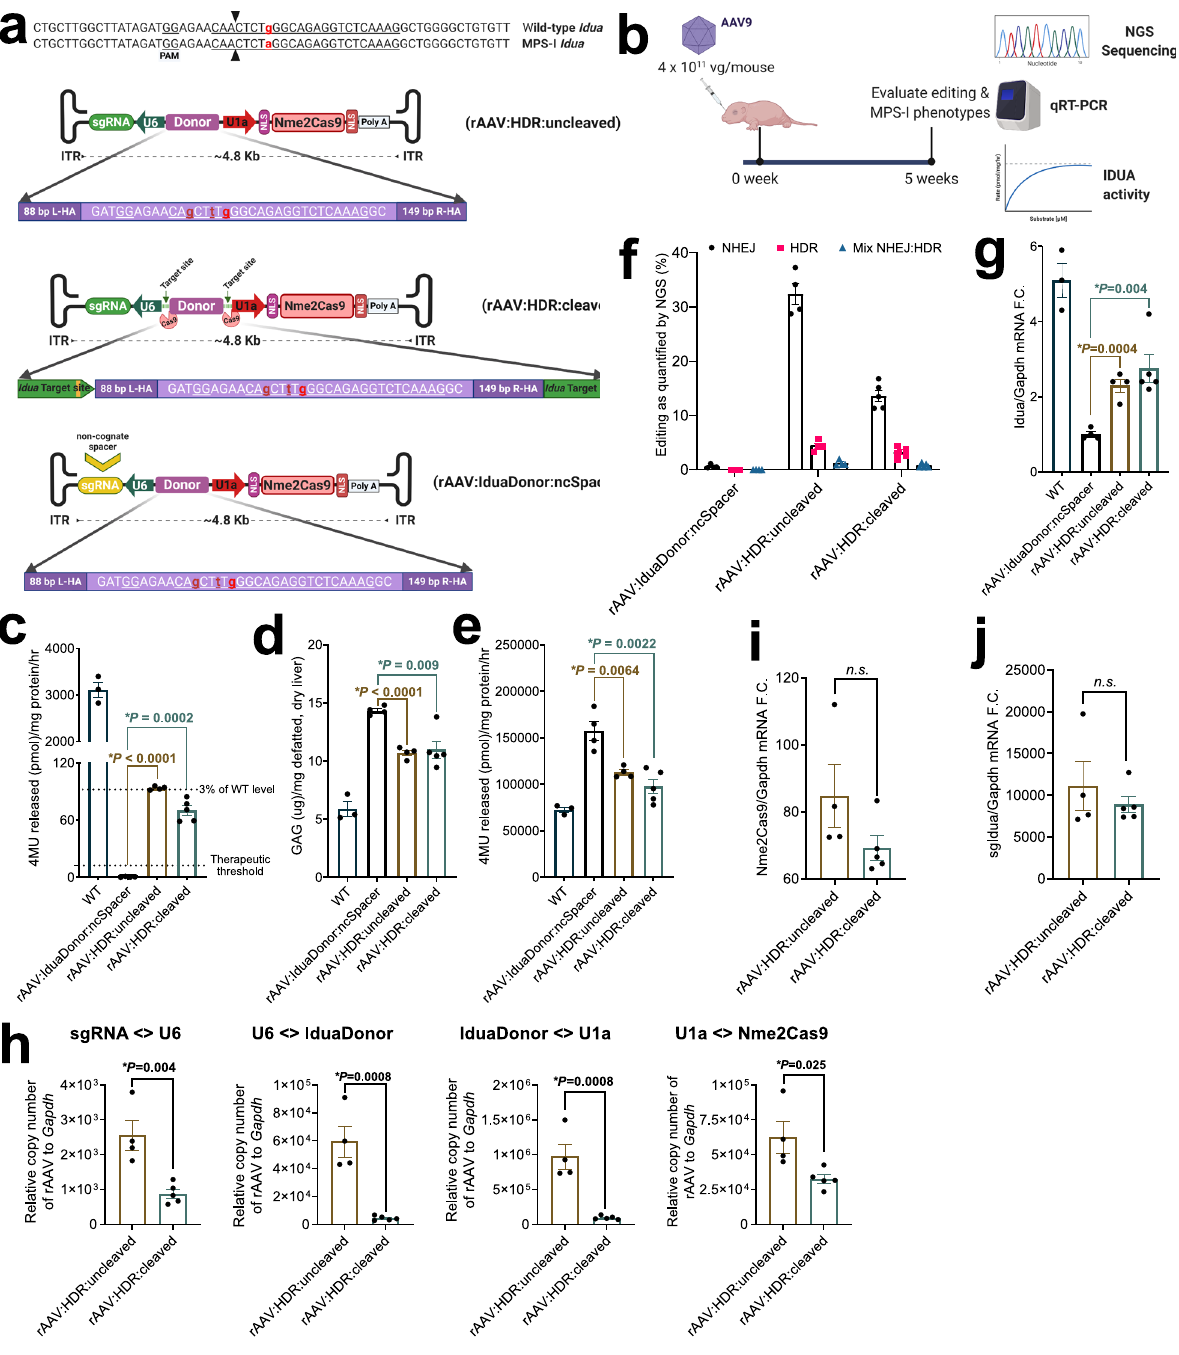
Fig. 5 Reduced clinical disease manifestation in a mouse model of mucopolysaccharidosis type I treated with rAAV:HDR vectors. a Schematic of rAAV:HDR:uncleaved, -cleaved, and control non-cognate spacer vectors to correct the Idua point mutation in MPS-I Idua W392X mice. b In vivo experimental regimen to correct the Idua mutation by injection of rAAV9 through the facial vein in neonate MPS-I mice. c IDUA speci fi c activity in liver lysates of healthy mice compared to rAAV:IduaDonor:ncSpacer mice (negative control) and treated rAAV:HDR uncleaved/cleaved cohorts. The dashed lines indicate 0.2% (therapeutic threshold) and 3% of the IDUA activity detected in lysates from WT mice. d Level of glycosaminoglycan (GAG) accumulation in the livers of the same mice shown in ( c ). e β - D -glucuronidase speci fi c activity in liver lysates of healthy mice compared to rAAV:IduaDonor:ncSpacer mice (negative control) and treated rAAV:HDR uncleaved/cleaved cohorts. f Bar graph showing the percentage of NHEJ, HDR, and imprecise NHEJ:HDR mix at Idua in the liver as measured by NGS sequencing of PCR amplicons from genomic DNA. g qRT-PCR data showing increase in the relative Idua mRNA in the liver normalized to Gapdh mRNA. h AAV copy numbers in MPS-I mouse liver tissues using the [sgRNA<>U6] [U6<>IduaDonor], [IduaDonor<>U1a], and [U1a<>Nme2Cas9] primer pairs. i , j Animals treated with rAAV:HDR:cleaved vectors exhibit reduced Nme2Cas9 mRNA (i) and sgRNA (j) expression levels as measured by qRT-PCR, though reductions do not reach statistical signi fi cance. Data in panels c – h are presented as mean values ± s.e.m. ( n = 3 mice in the WT cohort, n = 4 mice in the rAAV:IduaDonor:ncSpacer and rAAV:HDR:uncleaved cohorts, and n = 5 mice in the rAAV:HDR:uncleaved cohort). p values are calculated using Student ’ s t -test (two-sided).